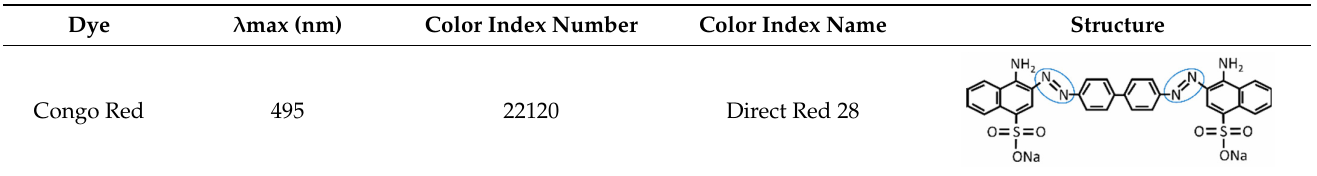
Table 1. Main features of Congo Red dye used to study the decolorization performance of the filters [9]. Azo-bonds labeled in blue circles.